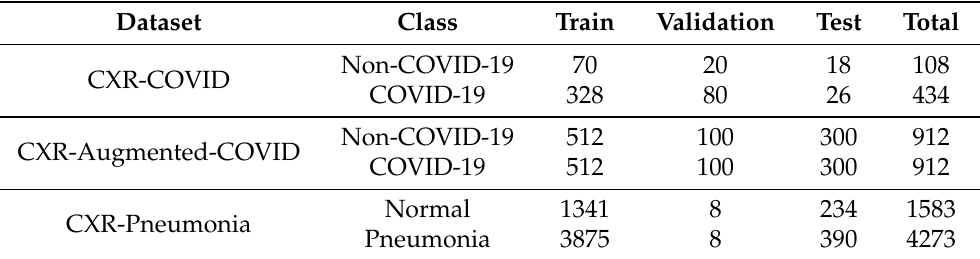
Figure 2. Illustrative sample of Chest X-Rays image with COVID-19 [43]. Table 1. Data